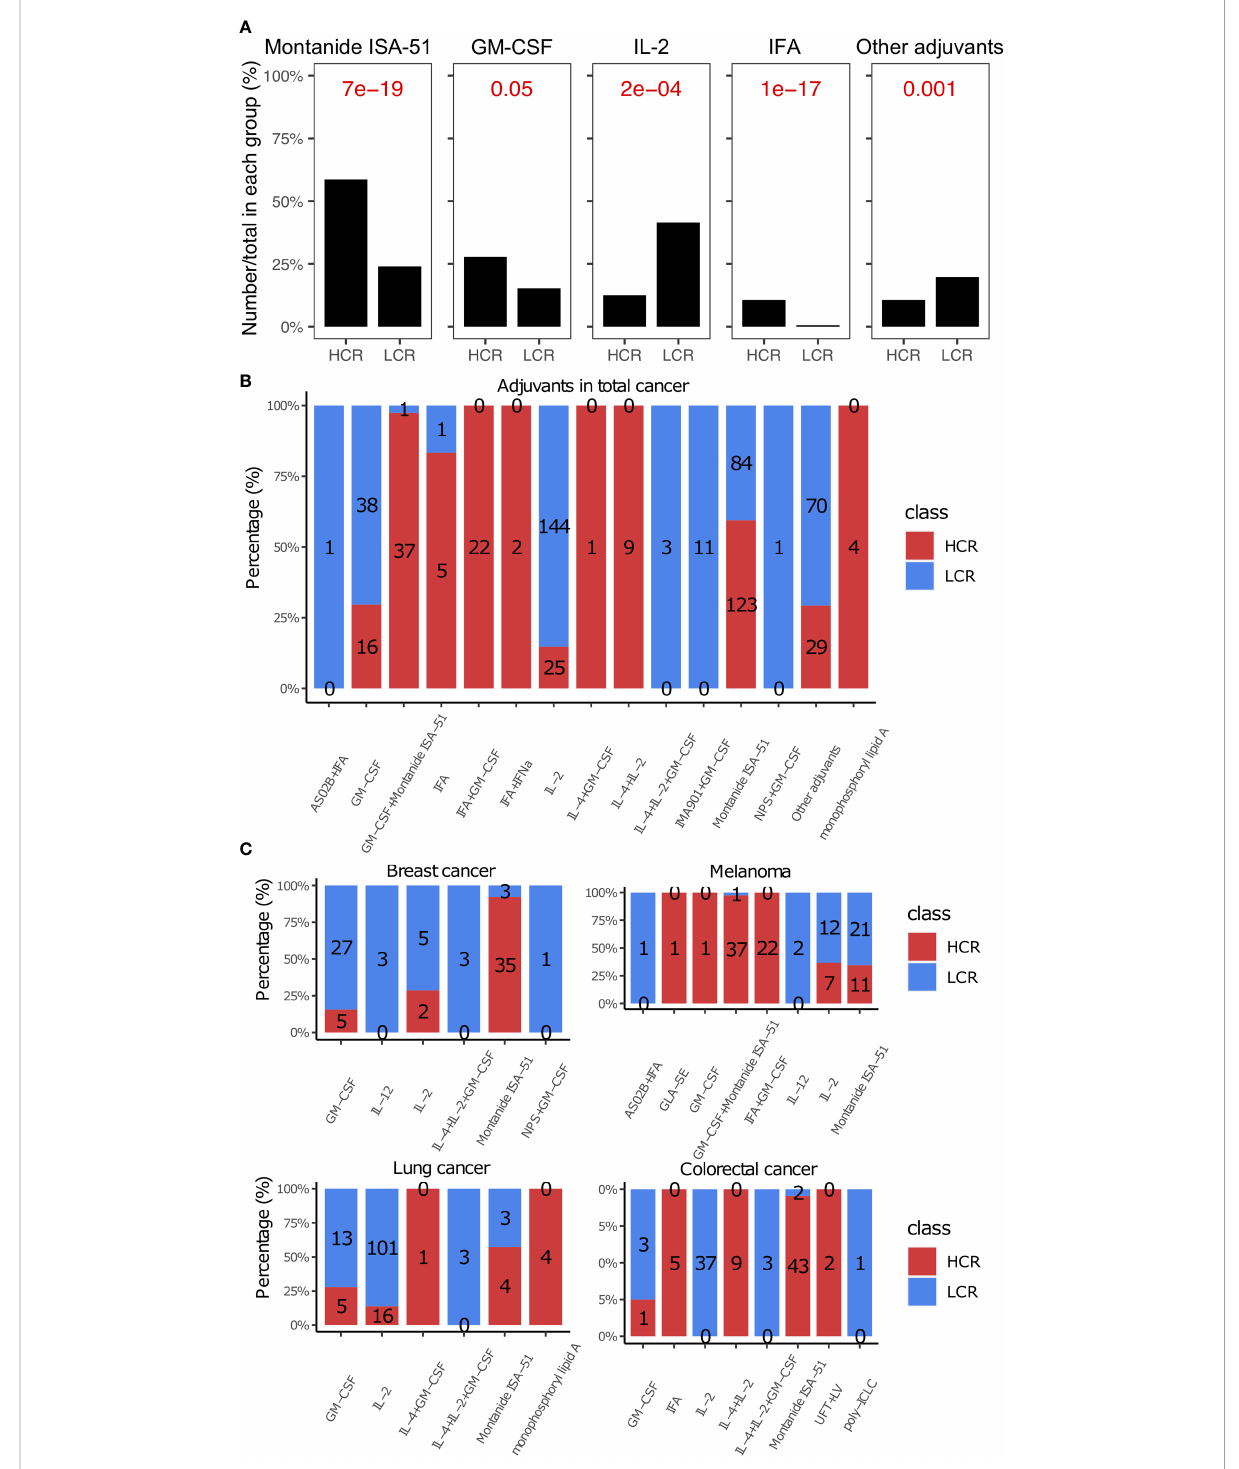
FIGURE 5 Adjuvants in high and low clinical response results. (A) Comparison of adjuvants between HCR and LCR results. (B) The distribution of adjuvants in HCR and LCR results. (C) The distribution of adjuvants in HCR and LCR results in four main cancer types (breast cancer, melanoma, lung cancer, and colorectal cancer). P-values were calculated using two-sided Wilcoxon rank-sum